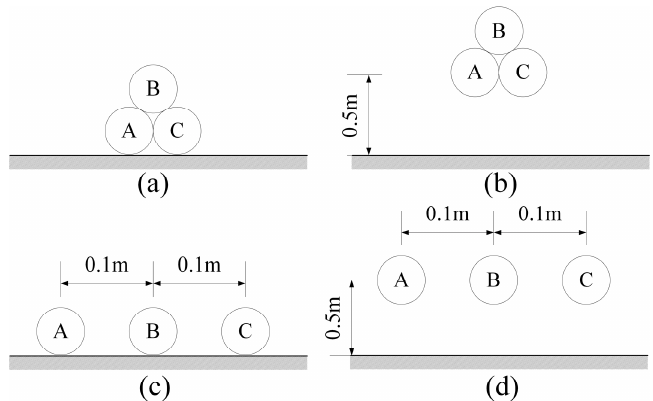
Figure 7. Laying configurations of cables. ( a ) Triangle arrangement, on the ground. ( b ) Triangle arrangement, 0.5m above the ground. ( c ) Horizontal arrangement, on the ground. ( d ) Horizontal arrangement, 0.5m above the ground.